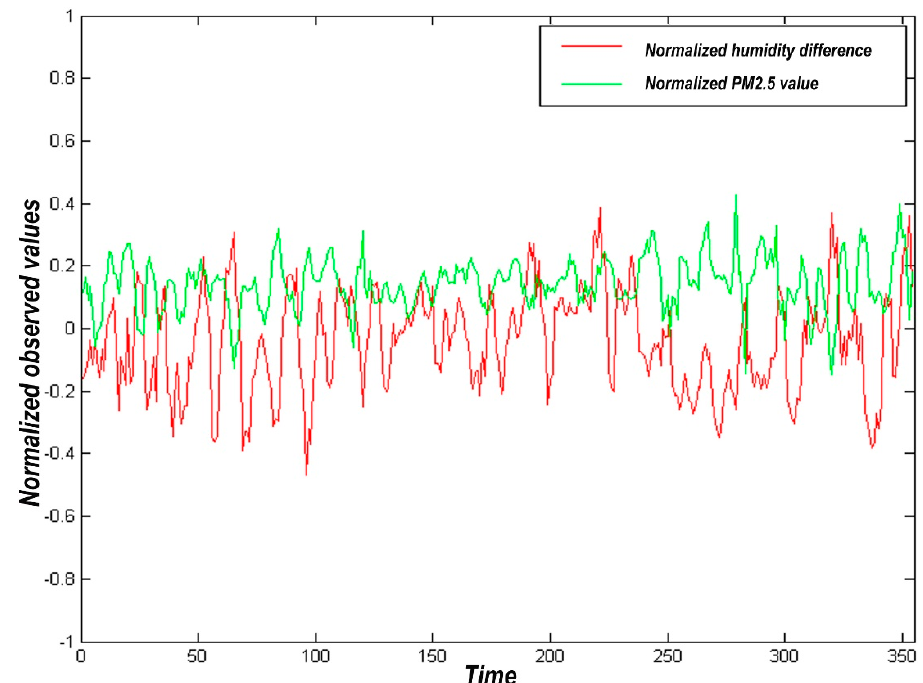
Figure 3. Correlation between humidity difference and PM2.5 difference.